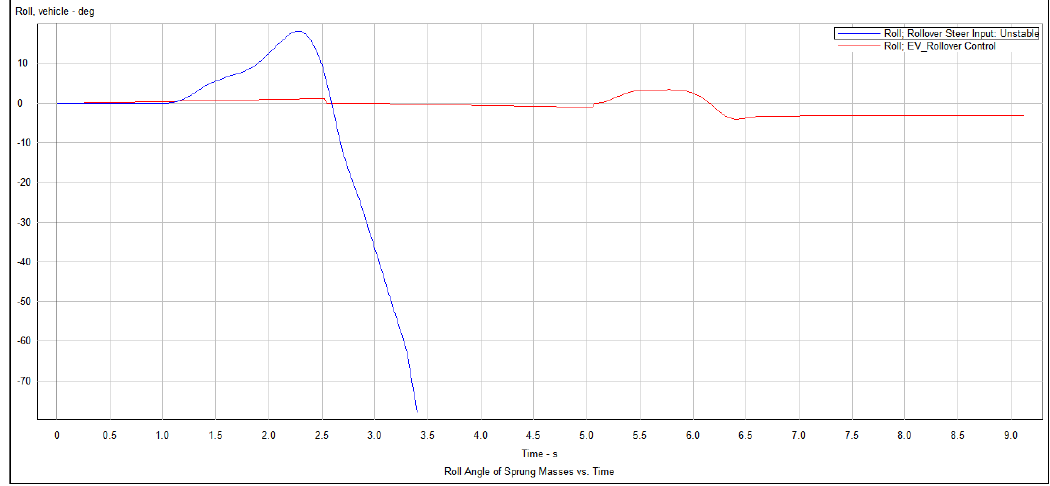
Figure 7. Roll angle comparison curve for fishhook test.